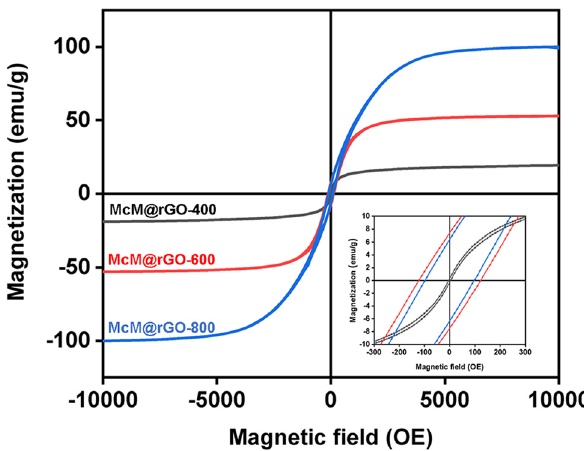
Figure 4: Hysteresis loops of the McM@rGO synthesized at di ff erent annealing temperatures. The inset provides an enlarged view of the loops in the range of − 300 to 300 OE.